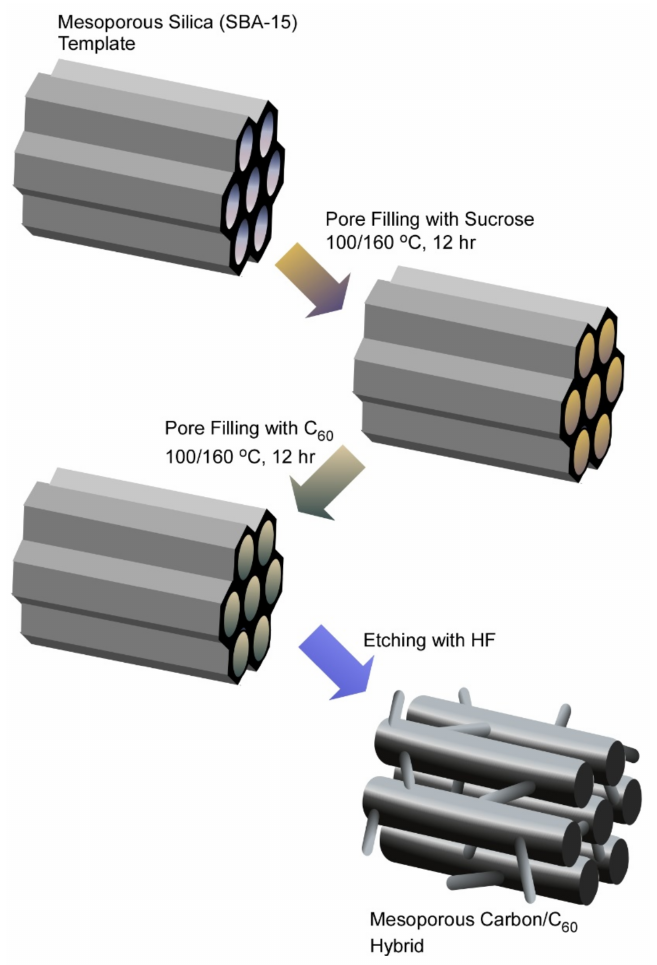
Figure 4. Preparation of mesoporous C 60 /carbon hybrid materials through nanotemplating method using mesoporous silica SBA-15 as a